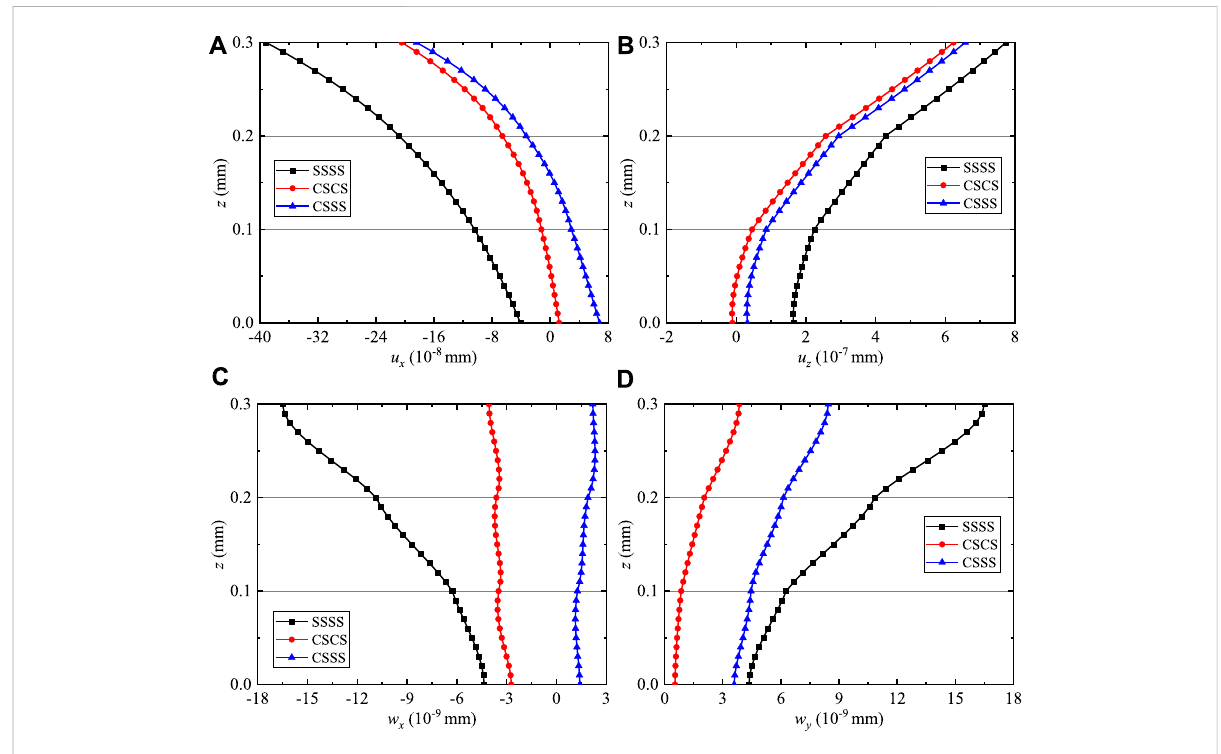
FIGURE 12 Variation of the phonon and phason displacements for QC coating structures: (A) u x , (B) u z , (C) w x , and (D) w y .